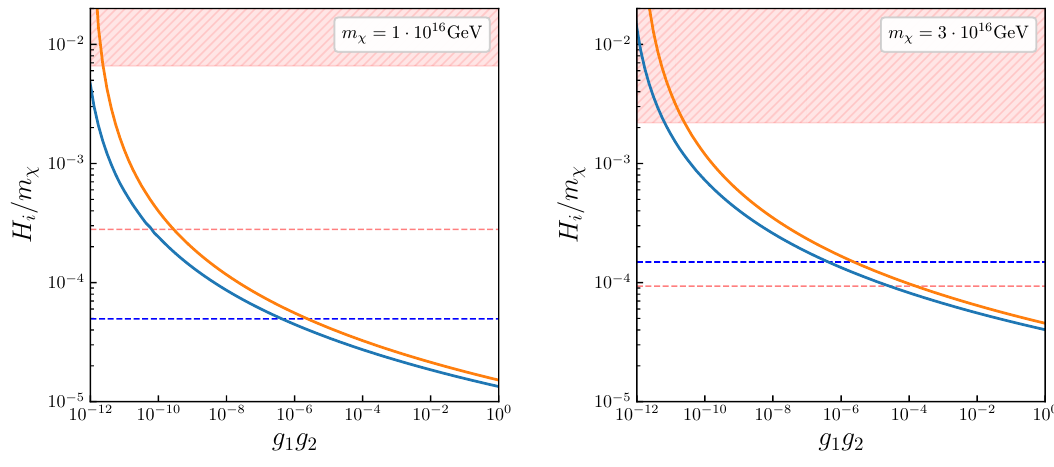
Figure 9. Plot of the critical Hubble rate at the end of in(cid:13)ation as a function of the product of the couplings, for a dark matter mass of 10 16 GeV (left) and 3 10 16 GeV (right). The blue (orange) (cid:1) curve indicates a mediator mass of 1 : 9 m (cid:31) (1 : 0 m (cid:31) ). The red area at the top is excluded by the currently observed bound for the tensor-to-scalar ratio in the CMB. Additionally, the projected sensitivity of CMB experiments is shown as the dashed red line. Furthermore, the critical Hubble rate of [4] is indicated by the blue dashed